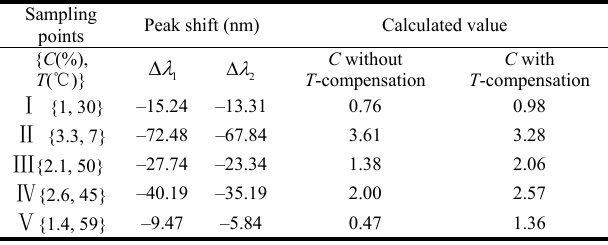
Table 6 Comparison of sensing data of various methane